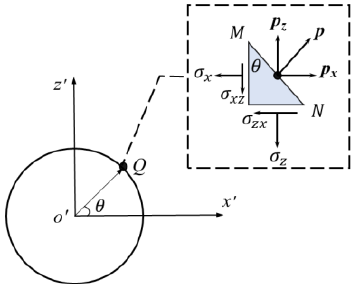
Figure 5. Stress at a point Q on the circular tunnel periphery.